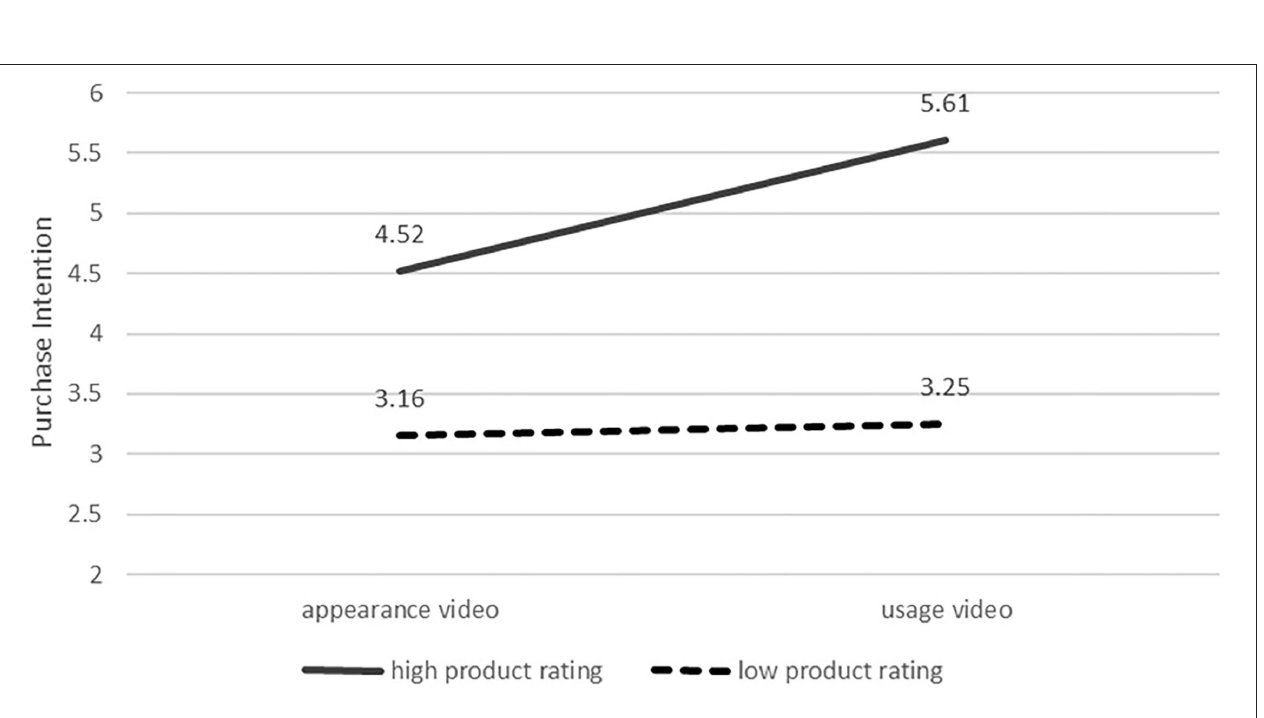
FIGURE 4 | Purchase intention in the different conditions of product